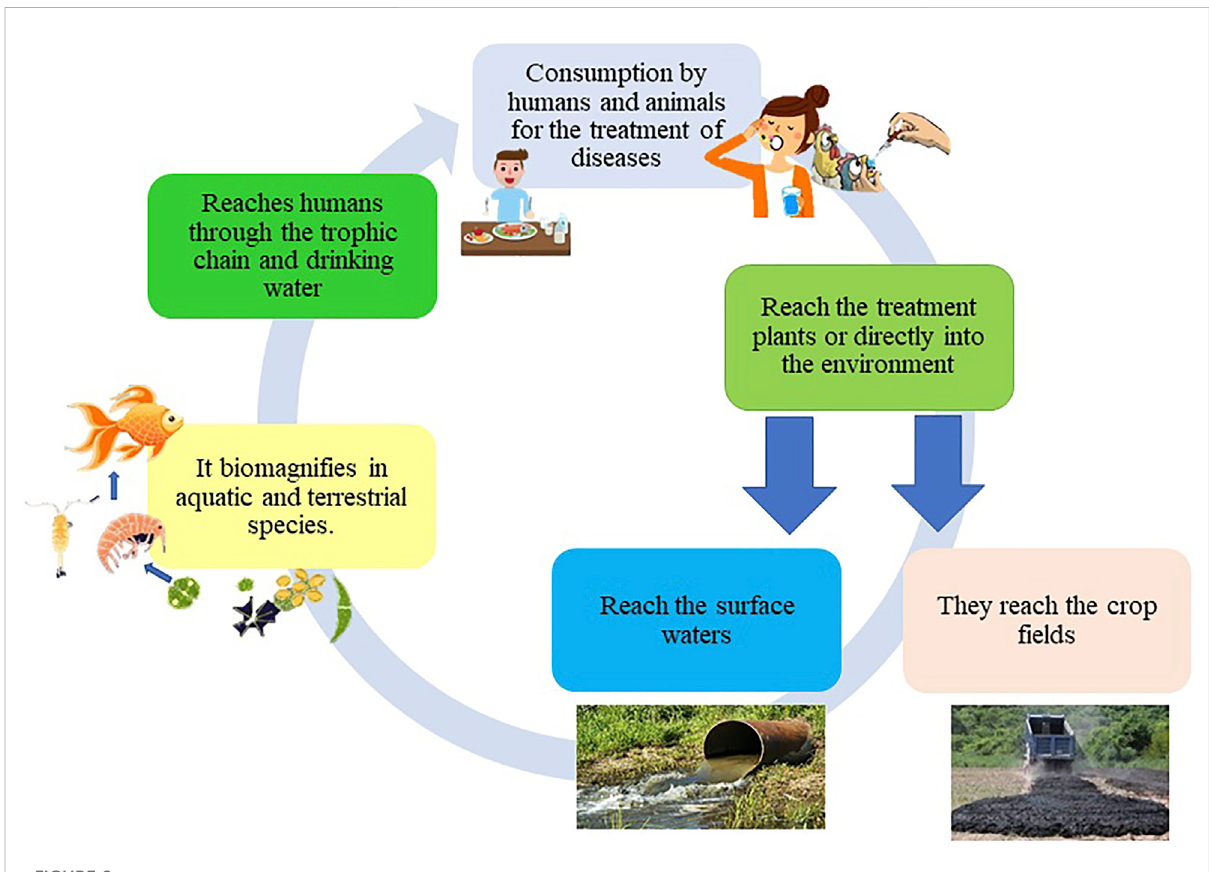
FIGURE 2 Use of pharmaceuticals and their release cycle in the